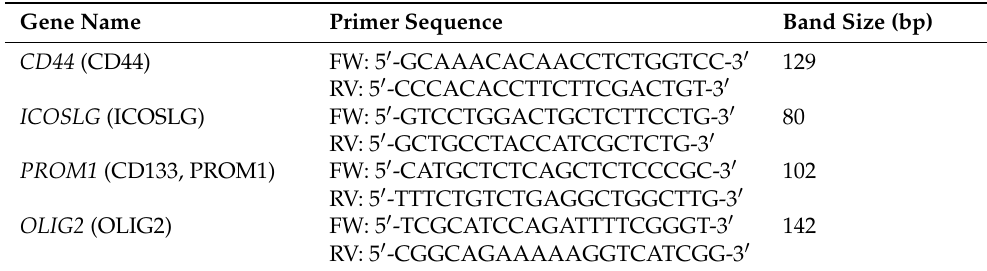
Table 1. Primer sets used in qRT-PCR